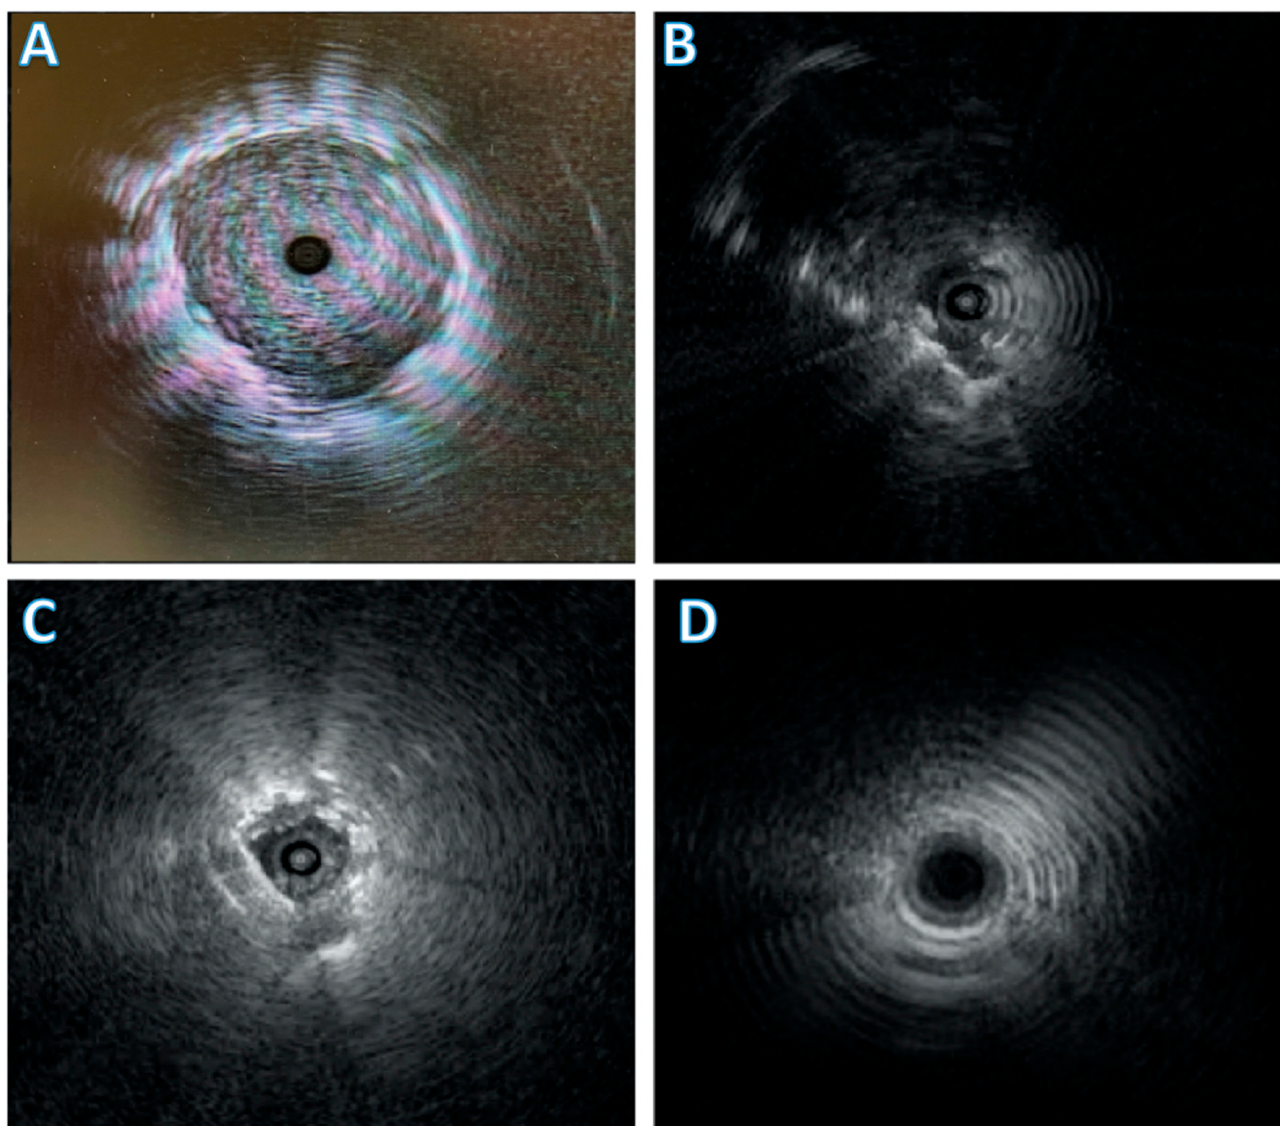
Figure 1. Different views obtainable with radial endobronchial ultrasound (REBUS). ( A ) demonstrates a concentric view with the REBUS probe in the center of the nodule. ( B ) is an eccentric view with the nodule visible off to the side of the REBUS. ( C ) demonstrates a blizzard pattern which can be seen with ground glass nodules [29]. ( D ) demonstrates no view.